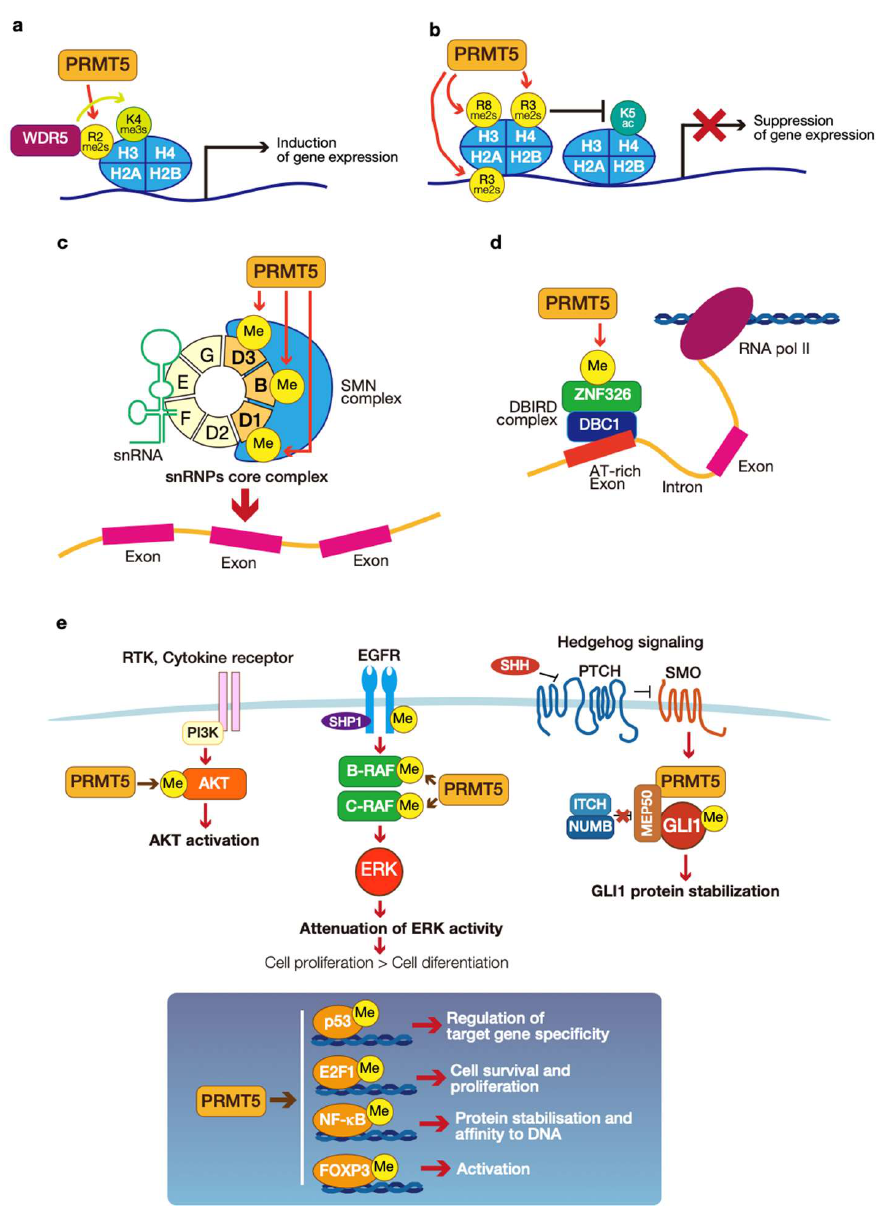
Figure 4. The roles of protein arginine methyltransferase 5 (PRMT5). ( a , b ): Schematic illustrations of PRMT5-mediated epigenetic regulation of gene expression. ( c , d ): The PRMT5-meditated mRNA splicing machinery. ( e ): PRMT5-mediated signal transduction and transcriptional regulatory molecules. Each figure is the author’s original image, illustrated using Adobe Illustrator